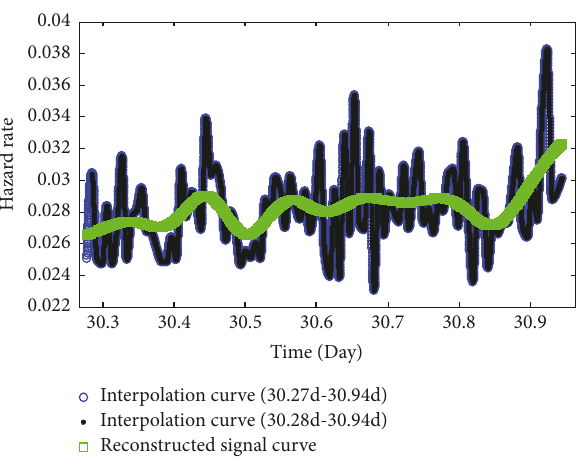
curveInterpolation curve (30.27d-30.94d) Interpolation curve Reconstructed signal Figure 9: The interpolation curve and the main trend of period (a).